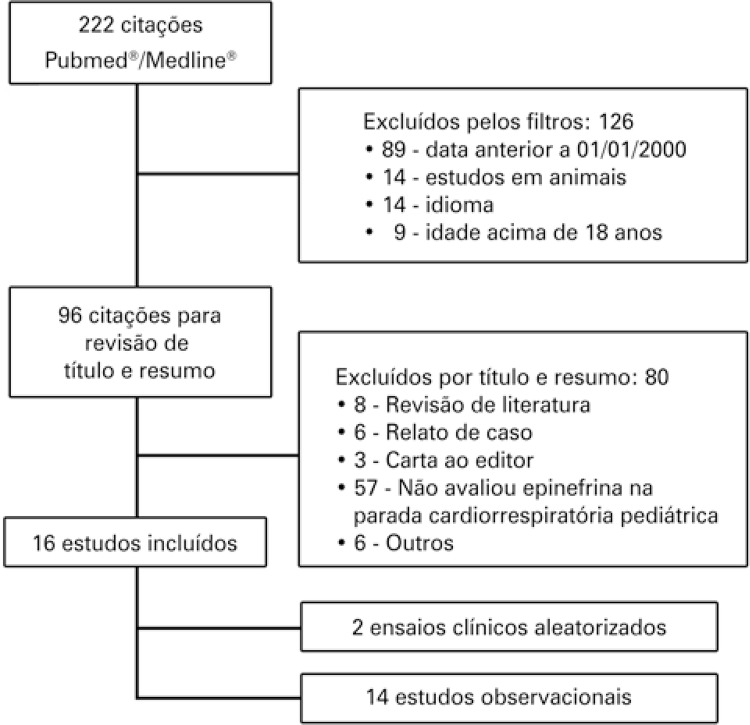
Fluxograma do estudo